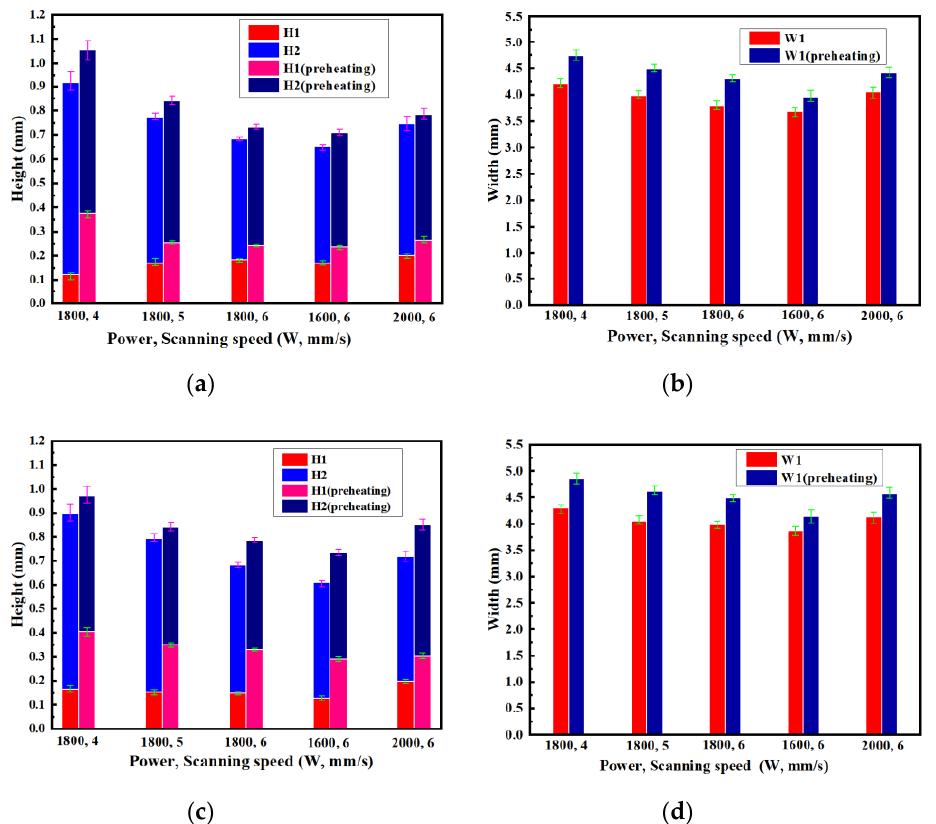
Figure 2. Effect of substrate preheating on calculated results under different process parameters: ( a ) Figure 2. E ff ect of substrate preheating on calculated results under di ff erent process parameters: height of 1045/316 L; ( b ) width of 1045/316 L; ( c ) height of P20/316 L; ( d ) width of P20/316 L. ( a ) height of 1045 / 316 L; ( b ) width of 1045 / 316 L; ( c ) height of P20 / 316 L; ( d ) width of P20 / 316 L. Crystals 2020 , 10 , x FOR PEER REVIEW